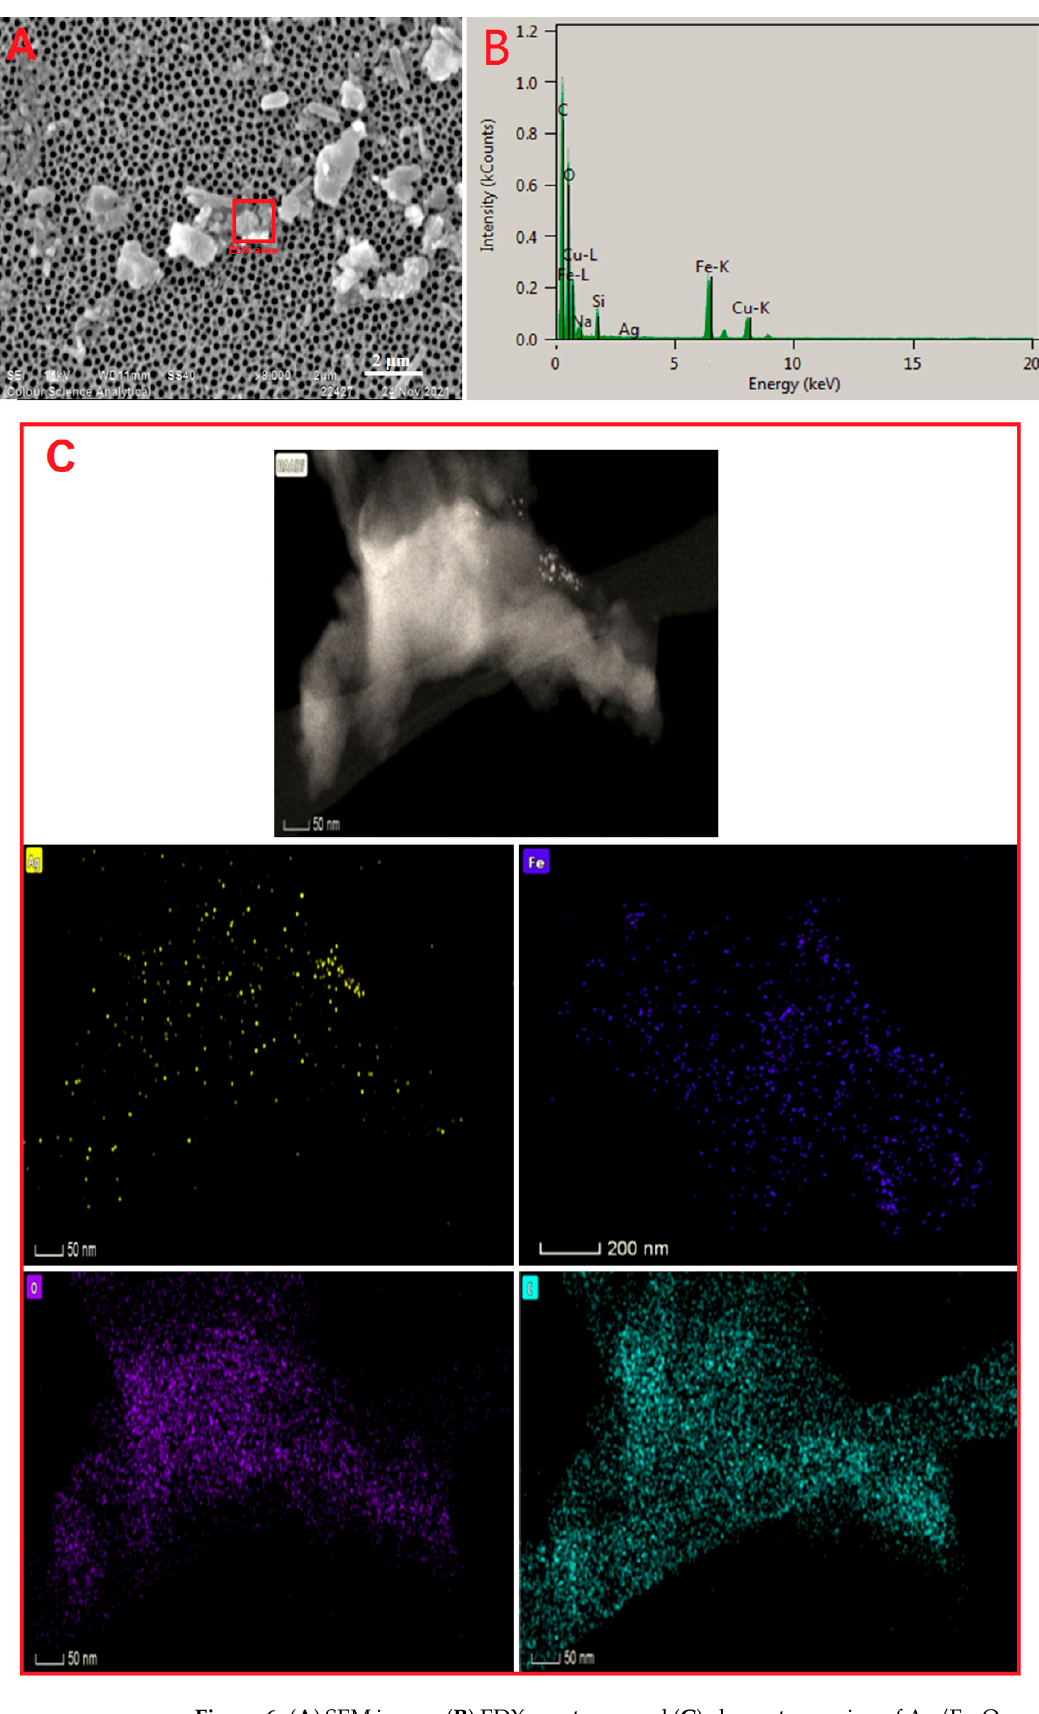
Figure 6. ( A ) SEM image, ( B ) EDX spectrum, and ( C ) element mapping of Ag/Fe 2 O 3 nanocomposites.